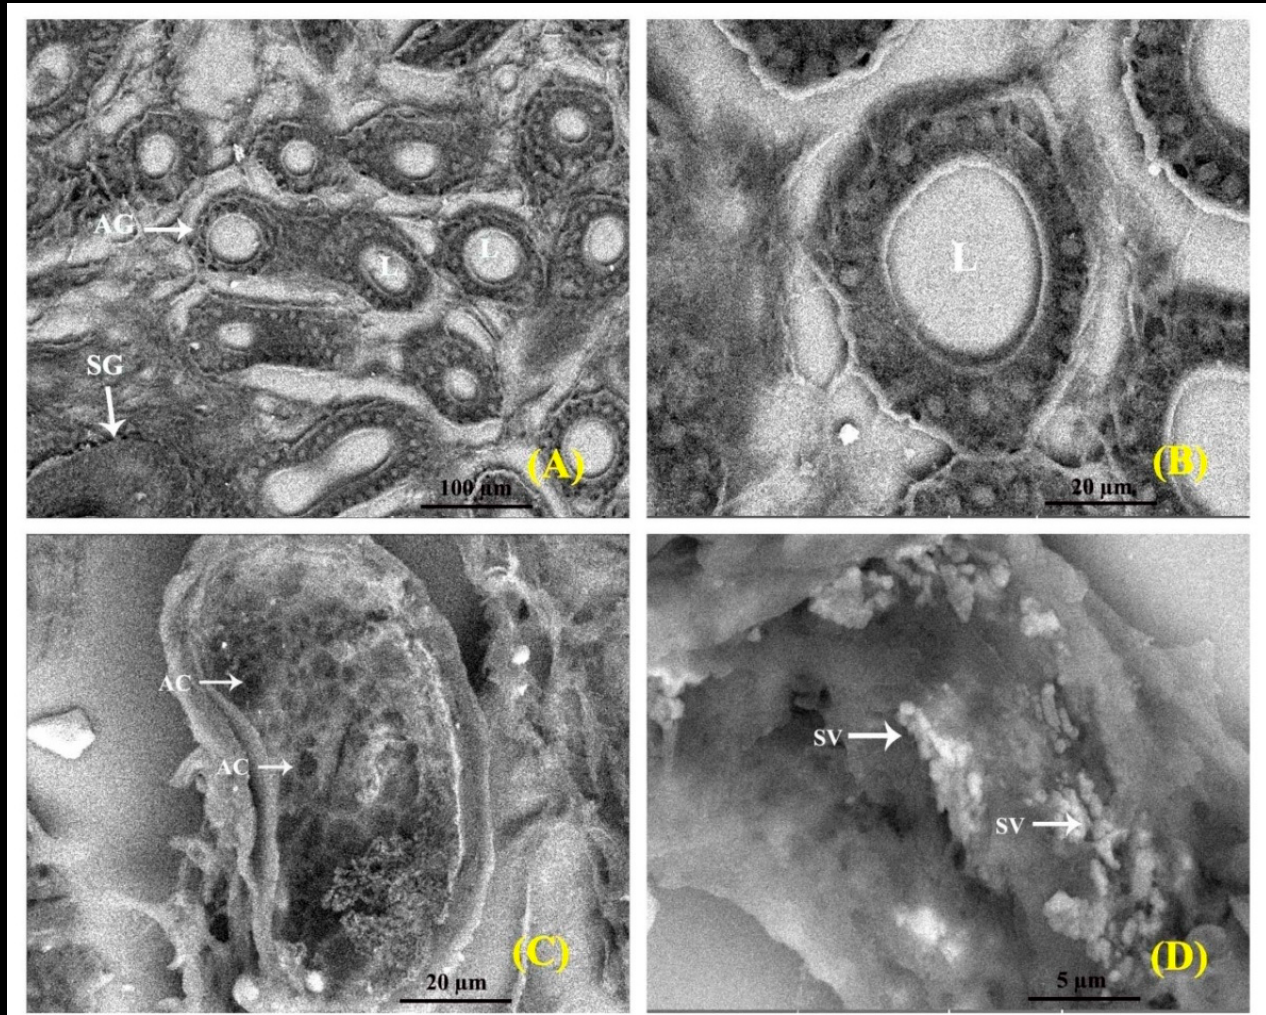
Figure 12. Scanning electron micrographs of the interdigital gland. The apocrine glandular lobules (AG) appear as a group of tortuous tubules found with sebaceous secretory lobules ( A ). The luminal surface shows a paved appearance ( B ); sebaceous glandular (SG) lobules with acinar cells (AC) ( C ); and secretory vesicles (SV) (arrows) with the secretory content present in the lumen (L) of the apocrine tubules ( D ).